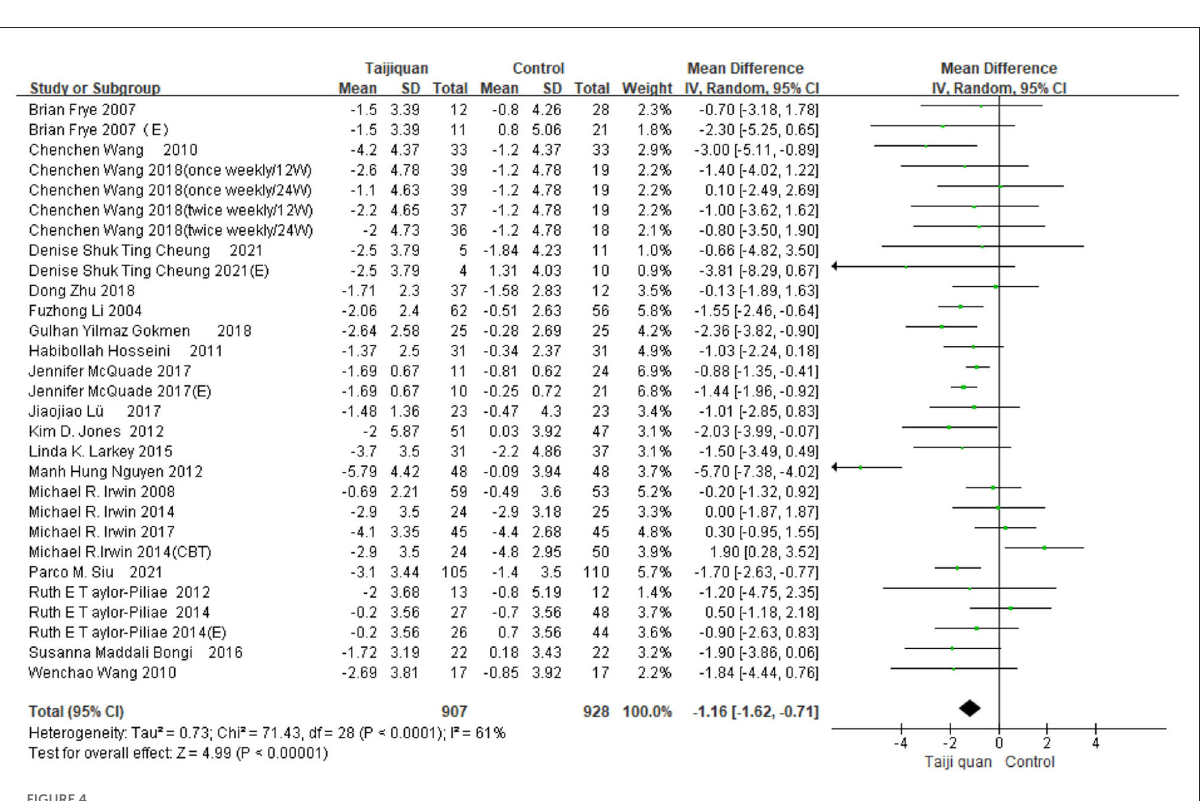
FIGURE4 Forest plot for PSQI meta-analysis was performed on all included